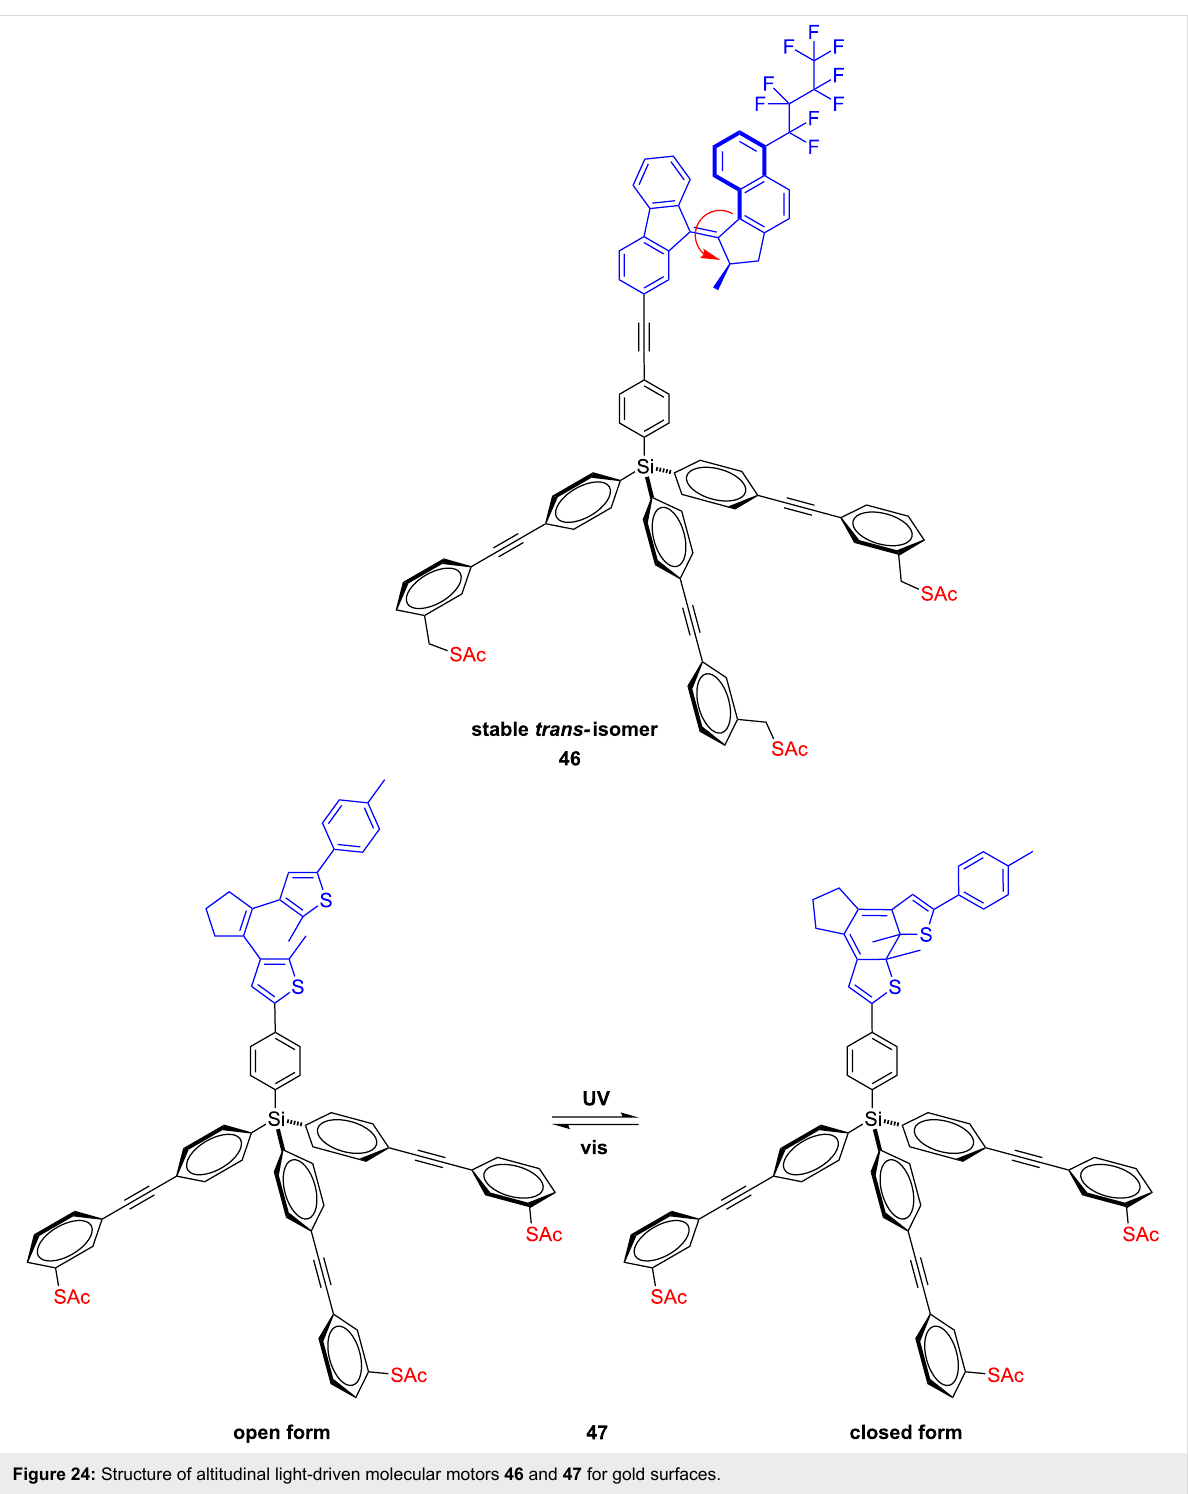
Figure 24: Structure of altitudinal light-driven molecular motors 46 and 47 for gold surfaces.